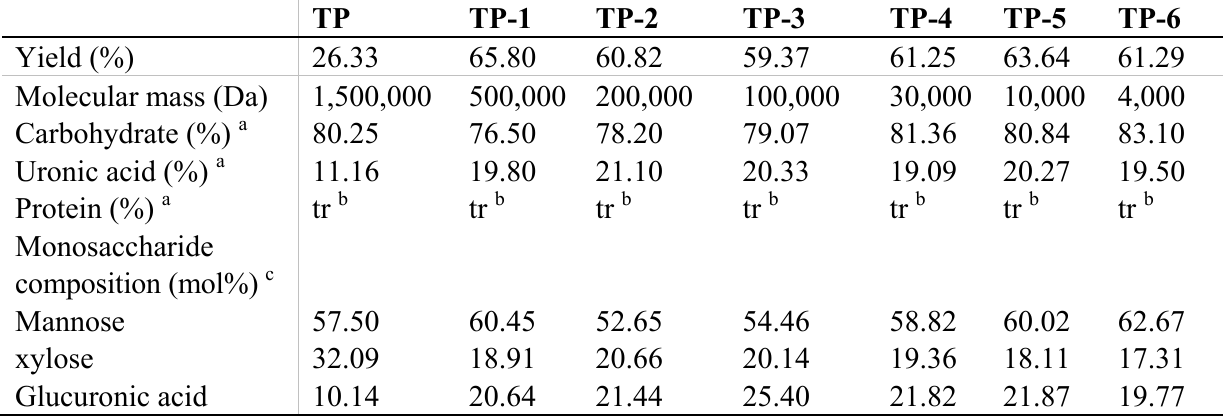
Table 1. Physicochemical properties, molecular mass and monosaccharide compositions of